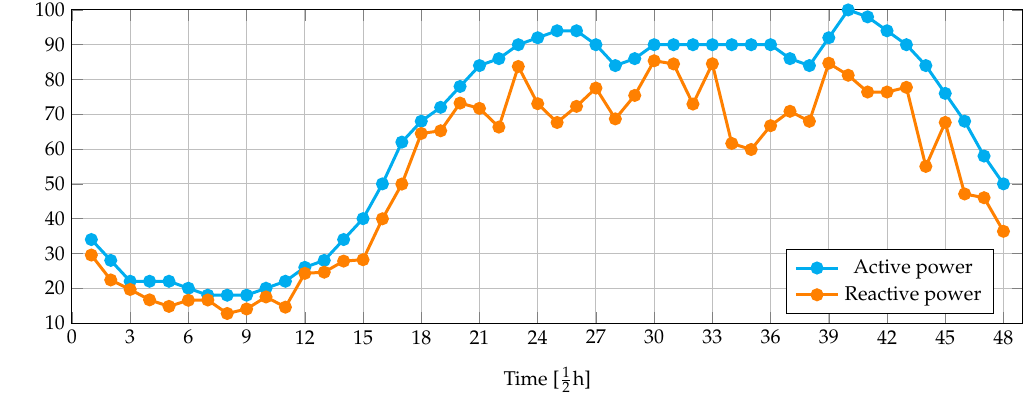
Figure 6. Typical behavior of active and reactive power consumption in Colombia